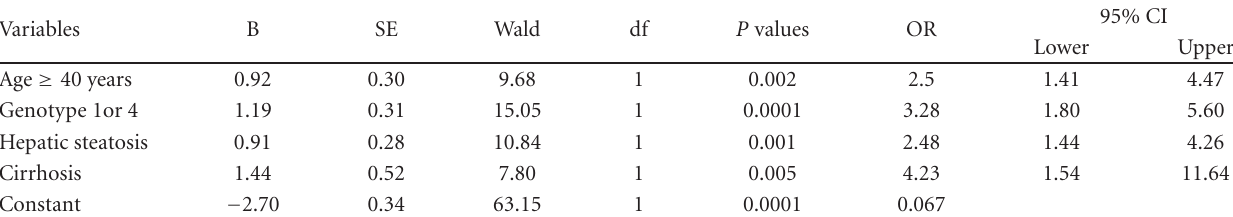
Table 3: Multiple logistic regression analysis for